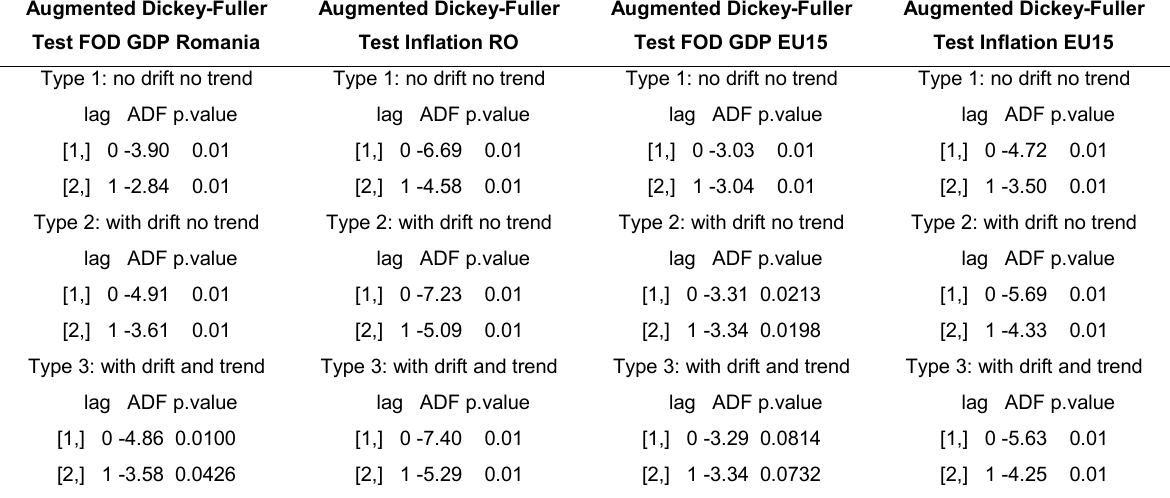
Table 3. Results of the Augmented Dickey-Fuller test for first-order difference (FOD) GDP and inflation for Romania and EU15 (2005-2019 sample). Note: only the case of these two economic entities has been included due to space